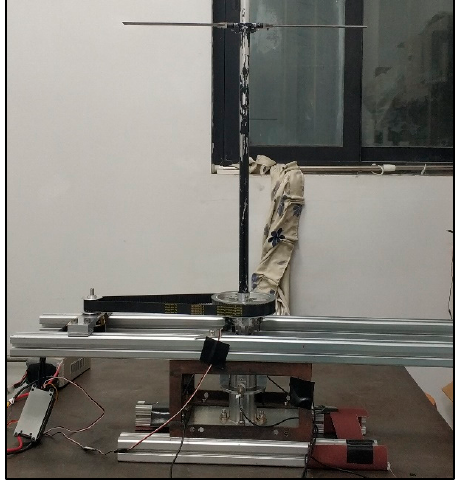
Figure 3. Rotor test stand.